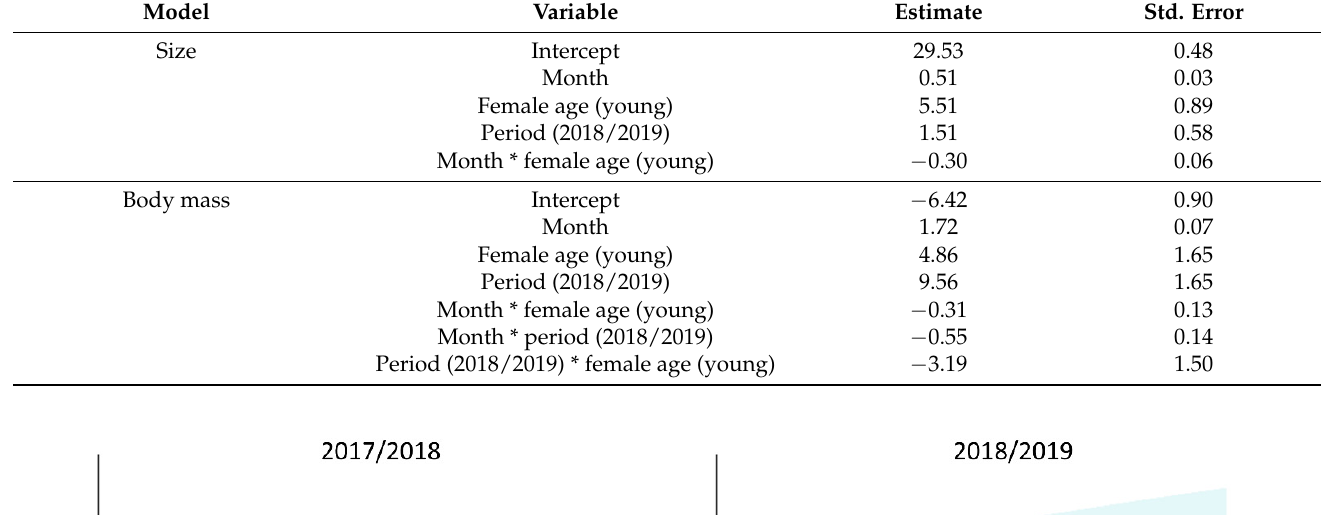
Table 2. Summary and statistical parameters of the final models for size (carapace length) and body mass. The individual was considered as a random factor, month as a continuous variable (from September to February) and female age (young or old females) and period (2017/2018 and 2018/2019) as factors. See electronic supplementary material (ESM) Tables S4 and S5 for model selection. * represents the interaction between the variables.